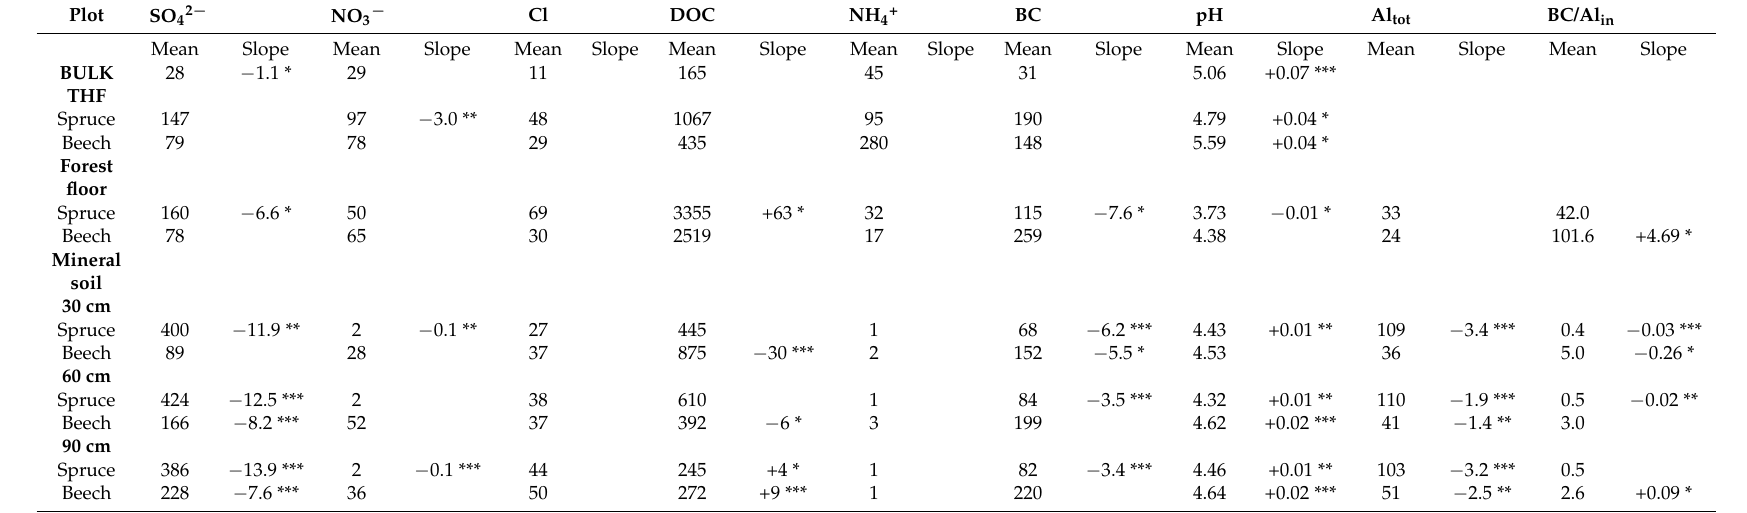
Table 1. Seasonal Mann-Kendall trends for bulk, throughfall and soil solution concentrations, pH and the BC/Al in ratio with mean values in µ eq · L − 1 (SO 42 − , NO 3 −